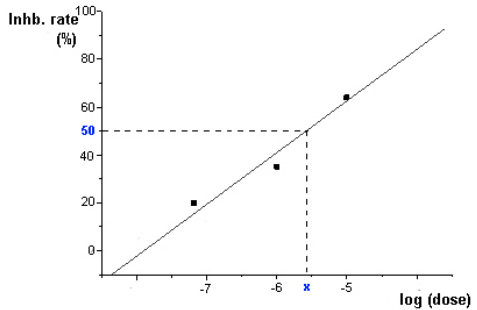
Figure 3. Exemplary dose-response curves for calculating IC 50 values.